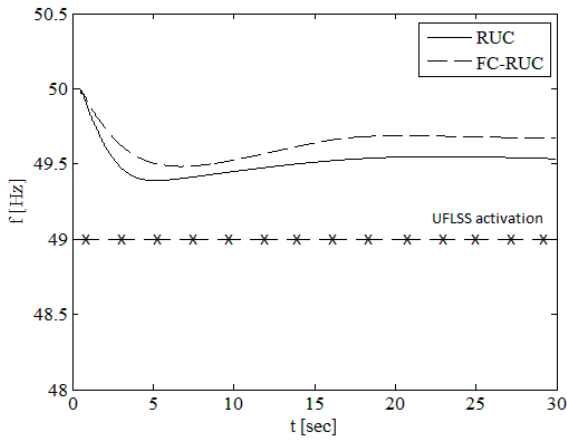
Figure 8. System frequency after the trip of generator G2, injecting 150 MW.